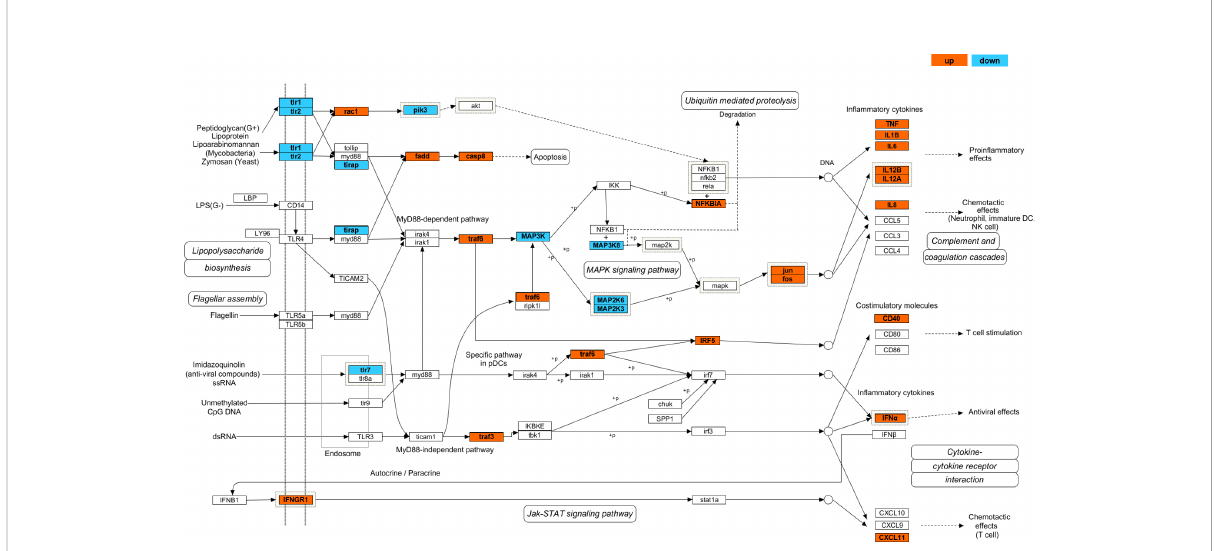
FIGURE 6 Predicted integrated Toll-like receptor signaling pathway in rainbow trout spleen. The pathway was constructed based on the pathway in Danio rerio (zebra fi sh) using PathVisio v3. Blue and red indicate a decrease and increase in any of component of the pathways, respectively, which contains D3 and D7 time points postinfection.